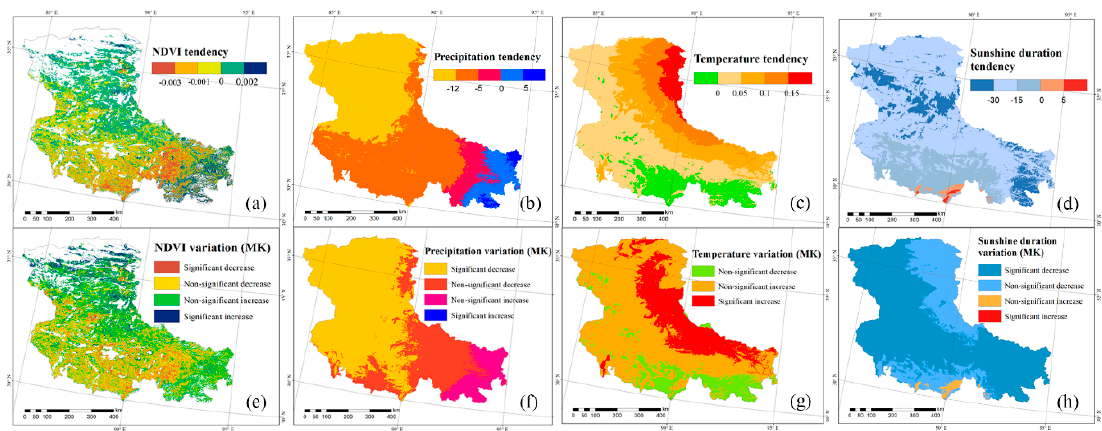
Figure 4. Spatial distribution of trends and corresponding significant levels of: ( a ) and ( e ) NDVI; ( b ) and ( f ) precipitation; ( c ) and ( g ) temperature; ( d ) and ( h ) sunshine duration, from 2000–2015 across northern Tibet.